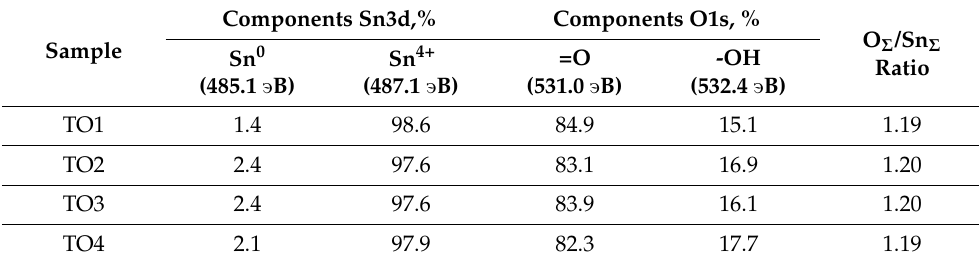
Table 3. Surface composition according to XPS